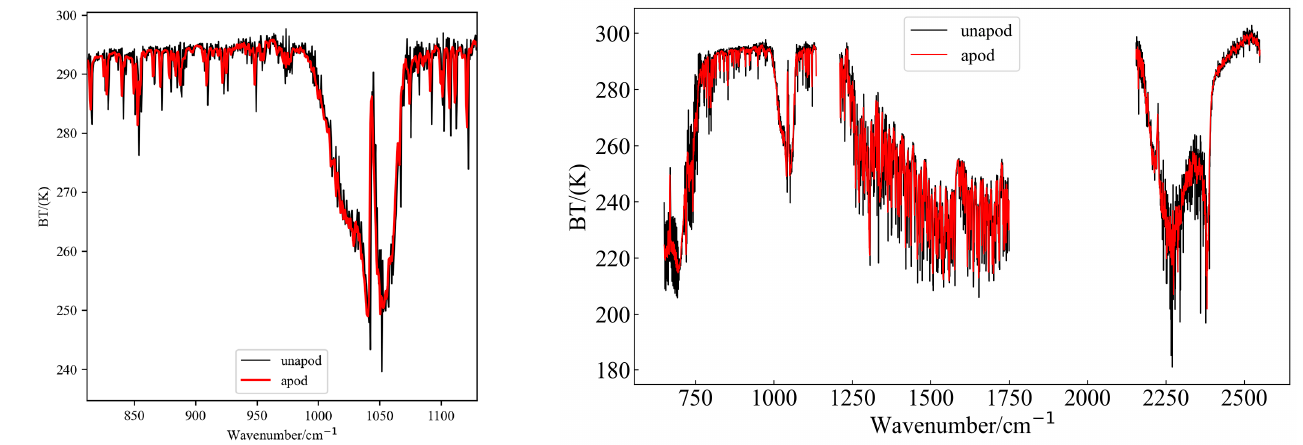
Figure 1. Comparison of light spectrum before and after apodization.